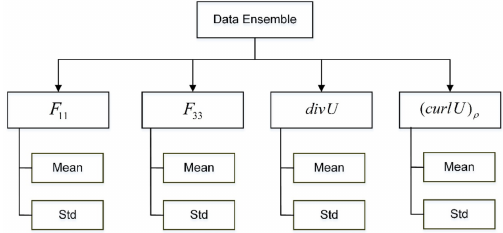
Figure 6. Experimental design: four kinematic properties— gradient along the ˆ ρ axis ( F 11 ), gradient along the ˆ y axis ( F 33 ), divergence ( div U ), and curl along the ˆ ρ axis ( ( curl U ) 3D-DIC-sampled displacement fields, and used for subsequent statistical